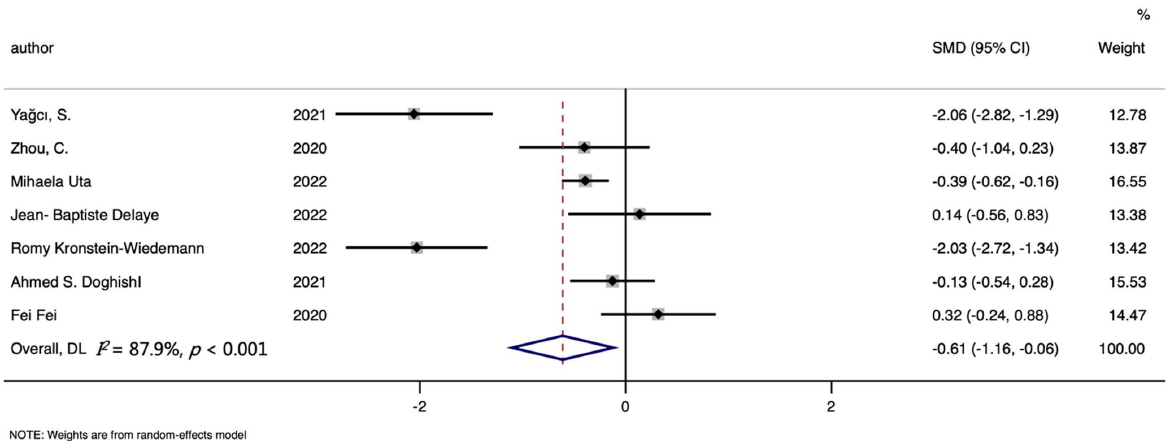
Figure 7. Forest plot of standard mean difference (SMD) with corresponding 95% confidence intervals (CIs) of studies [10,17–19,24,36,37] on hemoglobin levels in COVID-19 cases and controls. The solid diamond and horizontal line represent the study-specific effect and 95%CI, respectively; the size of the grey square is positively correlated with the weight distributed to each study in the meta-analysis. The center of open diamond with the vertical dashed line expresses the pooled SMD, and the width expresses the pooled 95%CI.